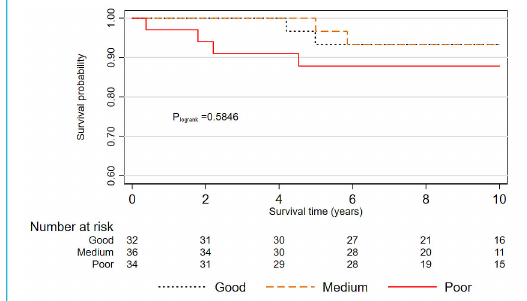
Figure 2: Breast cancer-specific survival in relatives according to familial survival categories (Kaplan-Meier method).